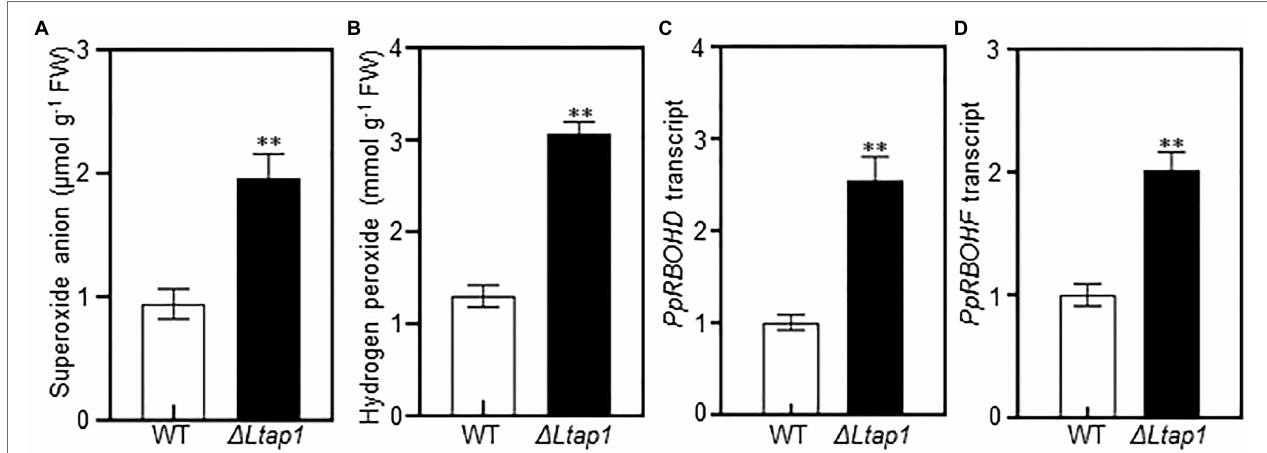
FIGURE 6 | Effect of LtAP1 deficiency on ROS generation and its related genes transcripts in infected peach shoots. (A,B) : Accumulation of superoxide anion and hydrogen peroxide in peach shoots inoculated with L. theobromae WT or Δ Ltap1 mutant at 5 dpi. (C, D) : Transcript abundance of ROS production-related genes PpRBOHD and PpRBOHF in infected peach shoots at 5 dpi. Relative transcript levels of genes compared with that of the control using reference gene PpTEF2 for normalization. All data are means ± SD of three biological replicates. Asterisks indicate the significant difference between two genotypes for the same parameter comparison at p <